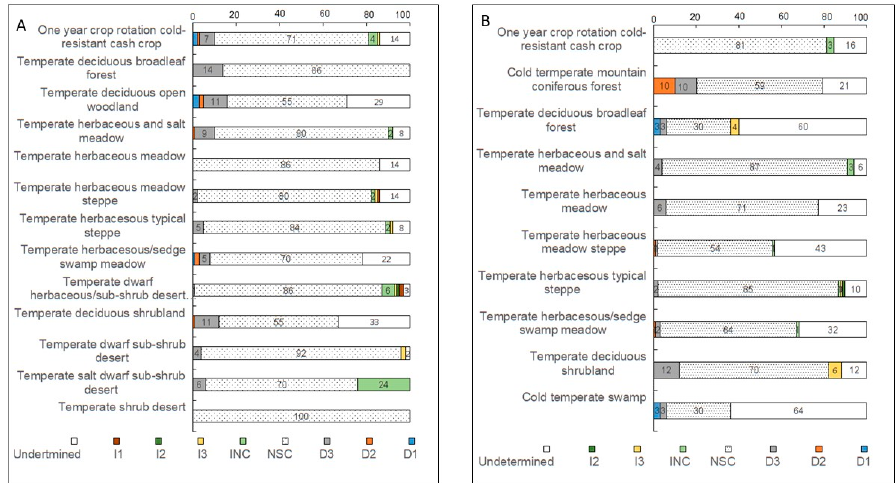
Figure 4. NDVI change direction (decrease/increase/no change) determined by TSS-RESTREND. ( A : Xilingol; B : Hulunbuir). We divided the significance of the linear regression of residual and time into four levels (0.01, 0.025, 0.05, and 0.1) with the F-test and classified nine variations in residual trends. The decreasing trend are D1 ( p < 0.01), D2 (0.01 ≤ p < 0.025), D3 (0.025 ≤ p < 0.05), and DNC (0.05 ≤ p < 0.1), and the increasing trend are I1 ( p < 0.01), I2 (0.01 ≤ p < 0.025), I3 (0.025 ≤ p < 0.05), and INC (0.05 ≤ p < 0.1). D1, D2, and D3 indicate obvious decreases in vegetative productivity, whereas I1, I2, and I3 represent increases. DNC and INC represent observable decreasing and increasing trends, respectively, with statistical significance between 0.05 and 0.1. The NSC refers to an insignificant statistical relationship in the trend of residual variation ( p > 0.1).